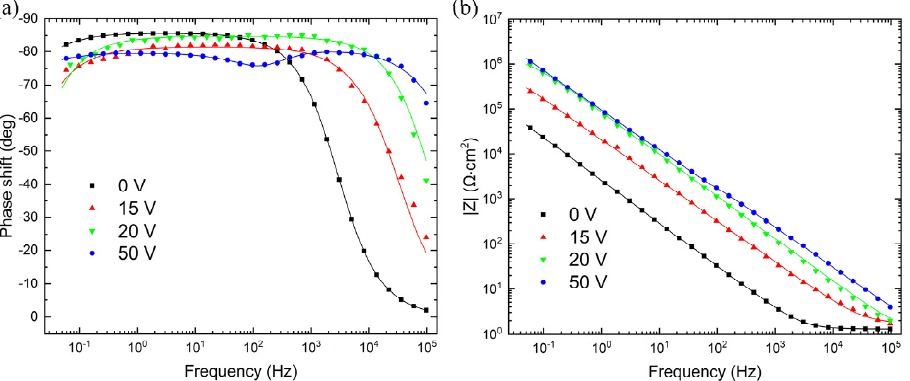
Figure 4. Impedance spectra for selected oxide films grown with different anodization voltage, obtained in 1.0 M H 2 SO 4 . ( a ) Phase shift, ( b ) magnitude of the impedance.